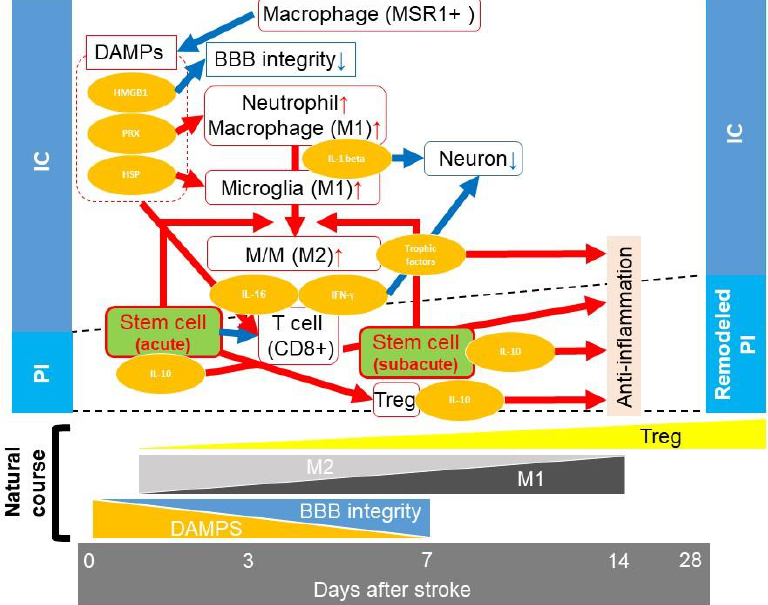
Figure 4. Summary of anti-inflammatory processes. After an ischemic stroke, the level of damage- associated molecular patterns (DAMPs) increases. DAMPs activate macrophages/microglia (M/M) (M1) and neutrophils. DAMPs also increase vessel permeability by decreasing blood-brain barrier (BBB) integrity, leading to infiltration of inflammatory cells into the infarct area. M/M (M1) secretes interleukin (IL)-1 beta, which injures neurons directly. From 3 days post ischemic stroke, MSR1- expressing macrophages, which scavenge DAMPS, increase up to 7 days post ischemic stroke. As DAMPs start decreasing, BBB integrity improves and neuroinflammation decreases. A few days post ischemic stroke, T cells infiltrate the infarct lesion. CD8+ T cells produce interferon- γ and IL-16, injuring neurons. Regulatory T cells (Tregs) gradually increase from the acute phase to 60 days post ischemic stroke. Tregs produce IL-10, reducing the infarct volume. In acute and subacute phase IA stem cell transplantation, stem cells switch the M/M polarization from M1 to M2, which reduces debris and secretes various trophic/growth factors. Stem cells also secrete IL-10. These effects contribute to reducing the infarct volume (red arrow, increase or enhancement; blue arrow, decrease or inhibition). IC: infarct core; PI: peri-infarct